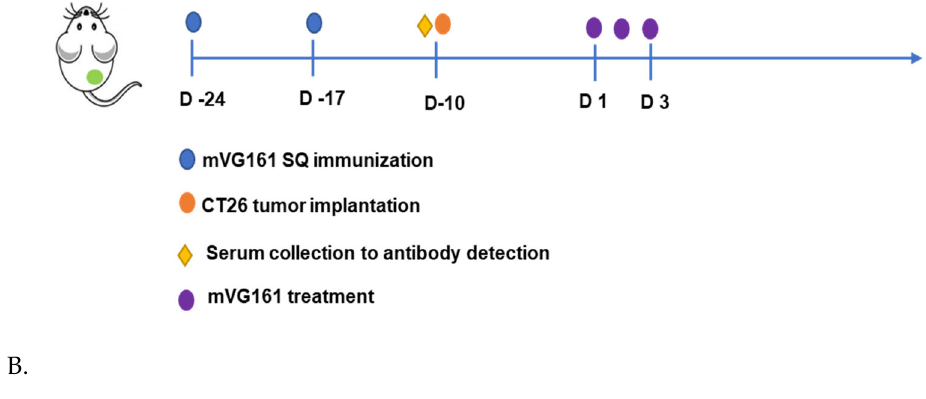
Table 1. Summary of mean ratio of T/C in single ‐ tumor model.